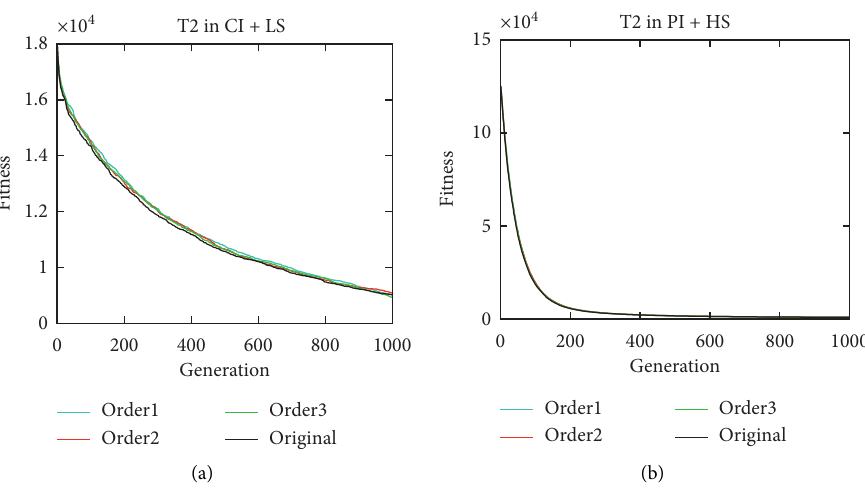
Figure 7: Convergence of MFEA for problem 4 (PI+HS).